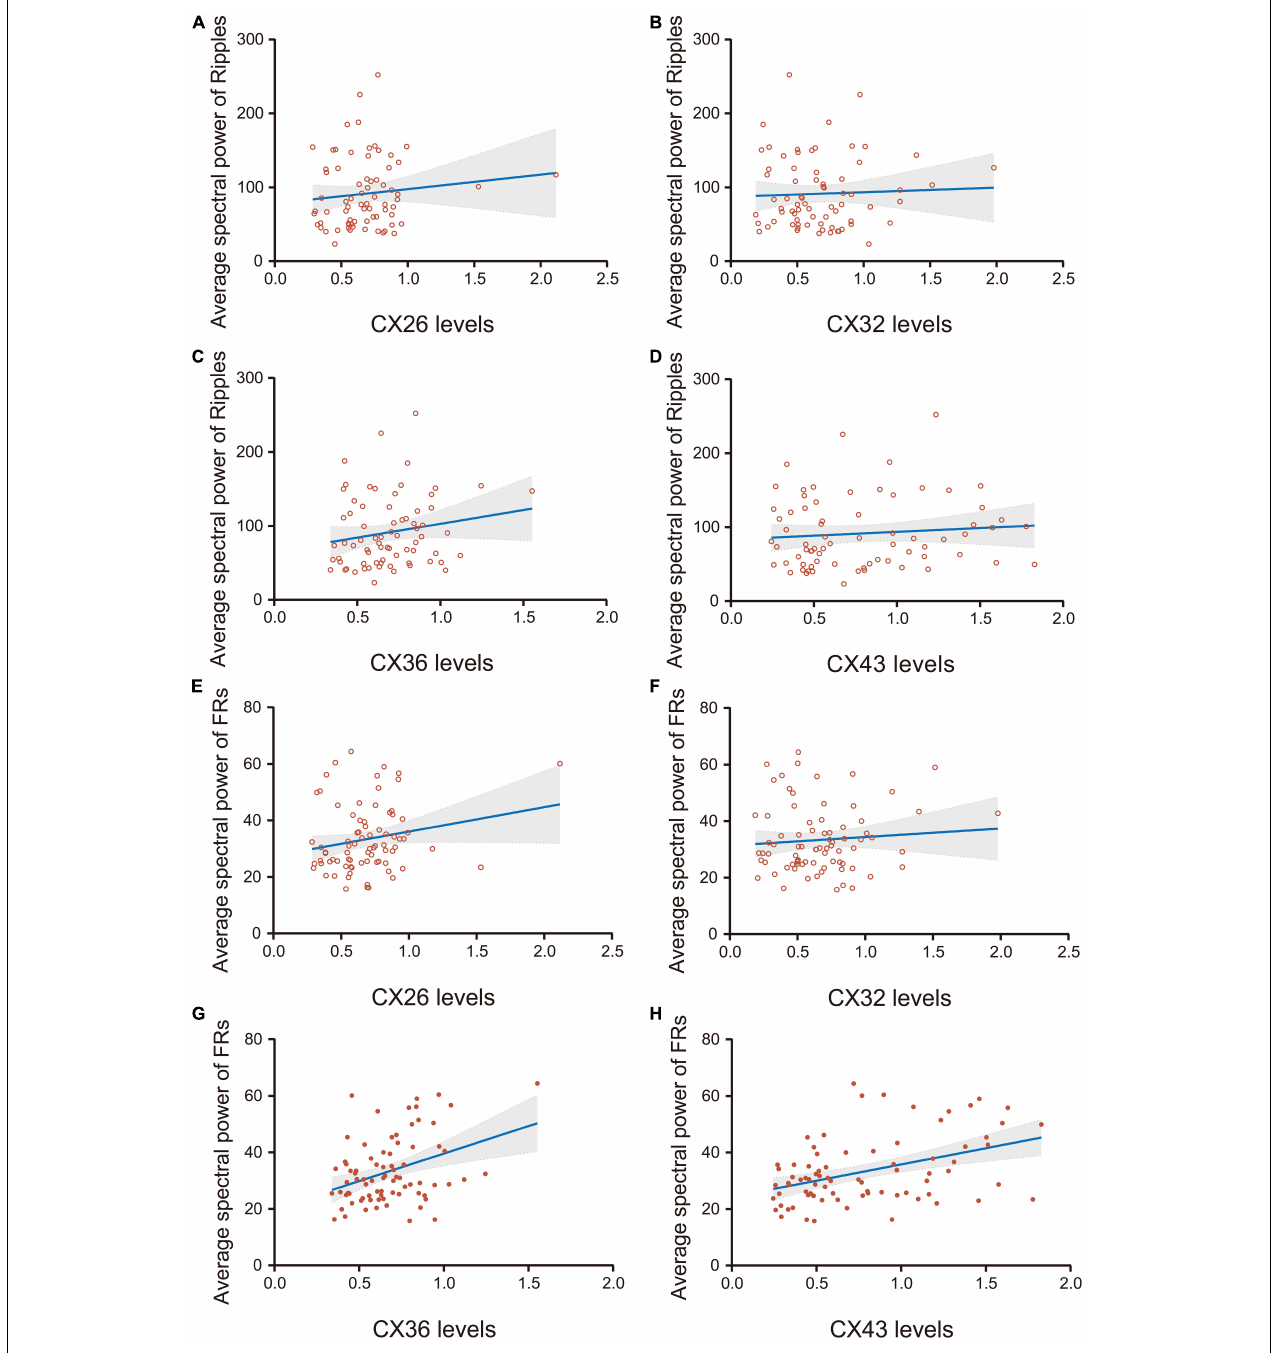
FIGURE 5 | Correlation analysis of the average spectral power of HFOs and the expression of CX26, CX32, CX36, and CX43. (A–D) There was no significant correlation between the average spectral power of ripples and the expression of CX26, CX32, CX36, or CX43 ( P > 0.05). (E,F) There was no significant correlation between the average spectral power of FRs and the expression of CX26 or CX32 ( p > 0.05). (G) The average spectral power of FRs was weakly correlated with CX36 expression ( r = 0.37, p < 0.05) and (H) moderately correlated with CX43 expression ( r = 0.42, p <